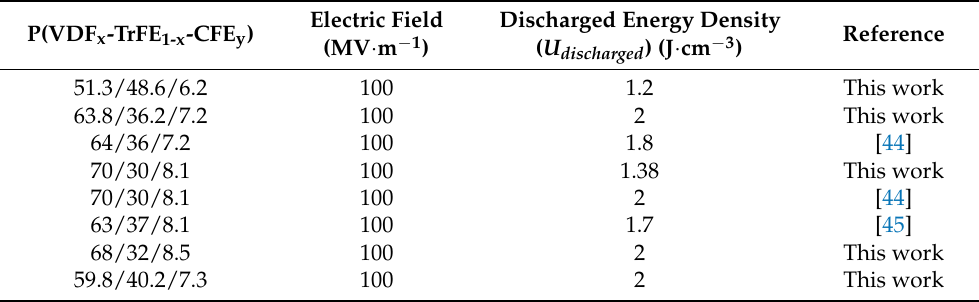
Figure 6. The discharged energy densities ( a ) and charge–discharge efficiencies ( b ) plotted against maximum applied electric field (estimated from the unipolar hysteresis loops shown in Figure S3). Table 4. Comparison of the discharged energy density for different P(VDF-TrFE-CFE) compositions.